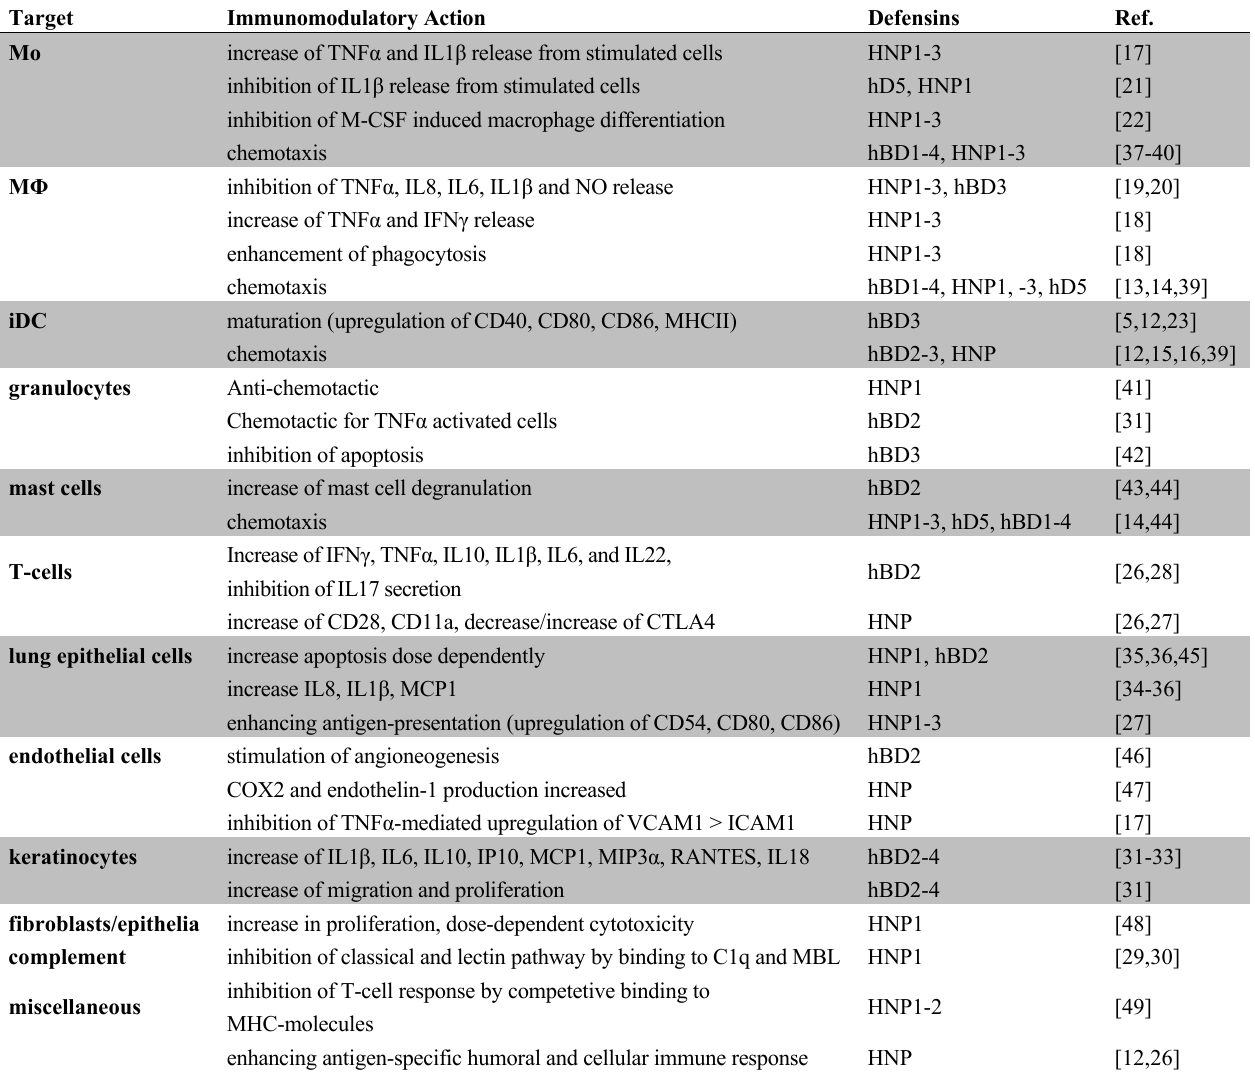
Table 1. Immunomodulatory functions of human